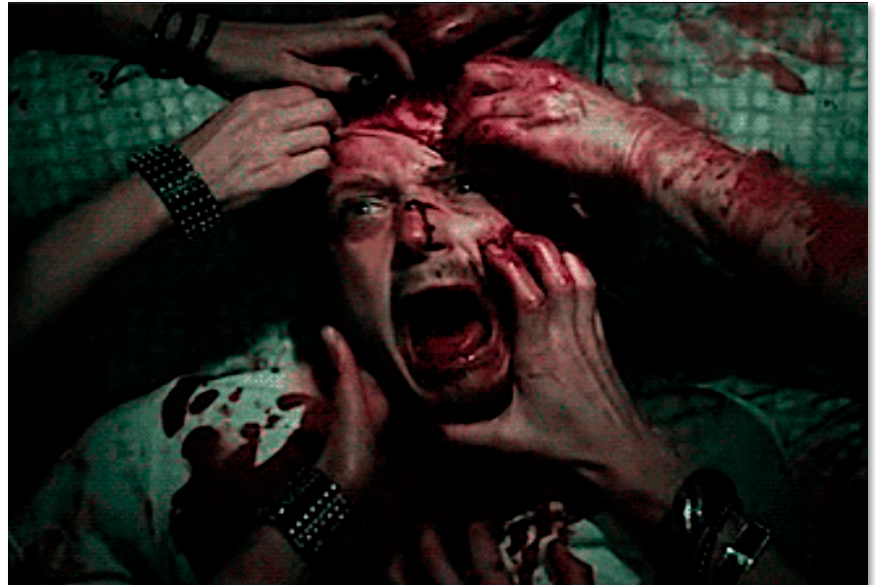
Figure 18. Image from Maniac (2012) [48].